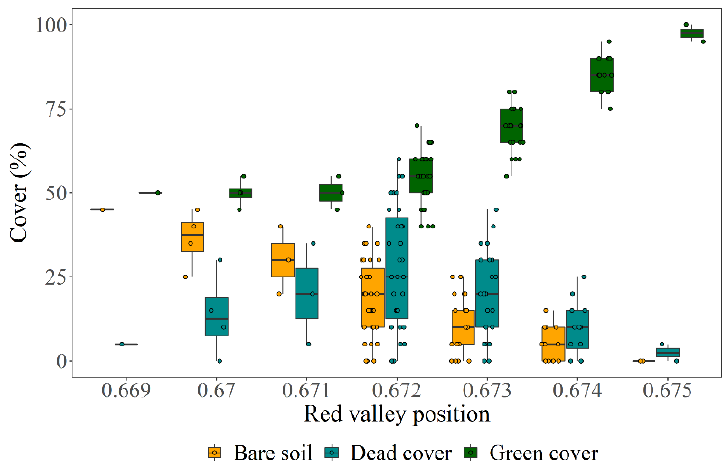
Figure 6. The influence of dead materials, green vegetation and bare soil on the red valley position based on the simulated hyper-spectra (i.e., only the spectra with clear red absorption characteristics were included in the